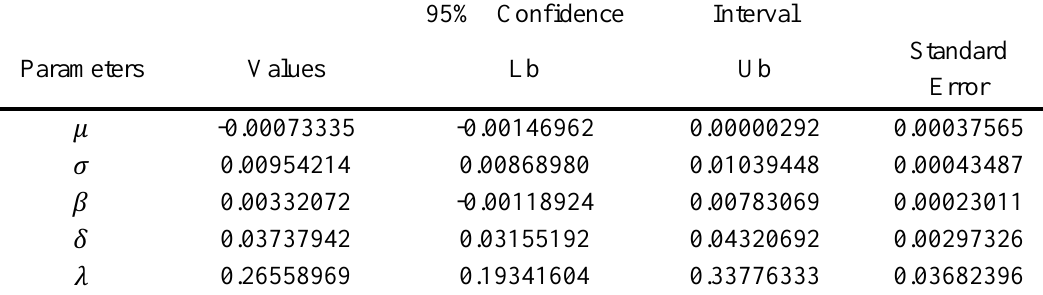
Table 2. Estimated parameters associated with WHGS3 sesame price under Merton’s